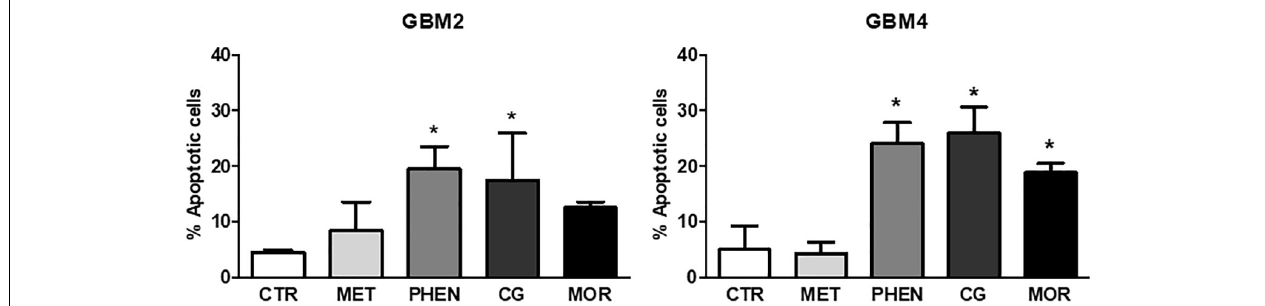
FIGURE 4 | Pro-apoptotic effects of metformin, phenformin, cycloguanil, and moroxydine on glioblastoma stem cells. Induction of apoptosis by biguanide treatment for 48 h was detected by annexin V binding, measured by FACS in GBM2 (left) and GBM4 (right) CSCs. Metformin did not significantly increase apoptosis neither in GBM2 nor in GBM4. Phenformin and cycloguanil increased apoptotic cell number in both GBM2 and GBM4 CSCs, while moroxydine significantly affected only GBM4 CSCs. Bars represent the percentage of annexin V-positive cells ± SEM, counting 10,000 events per experimental points. Experiments were repeated twice using independent cell preparations. ∗ p < 0.05, vs. CTR ( t